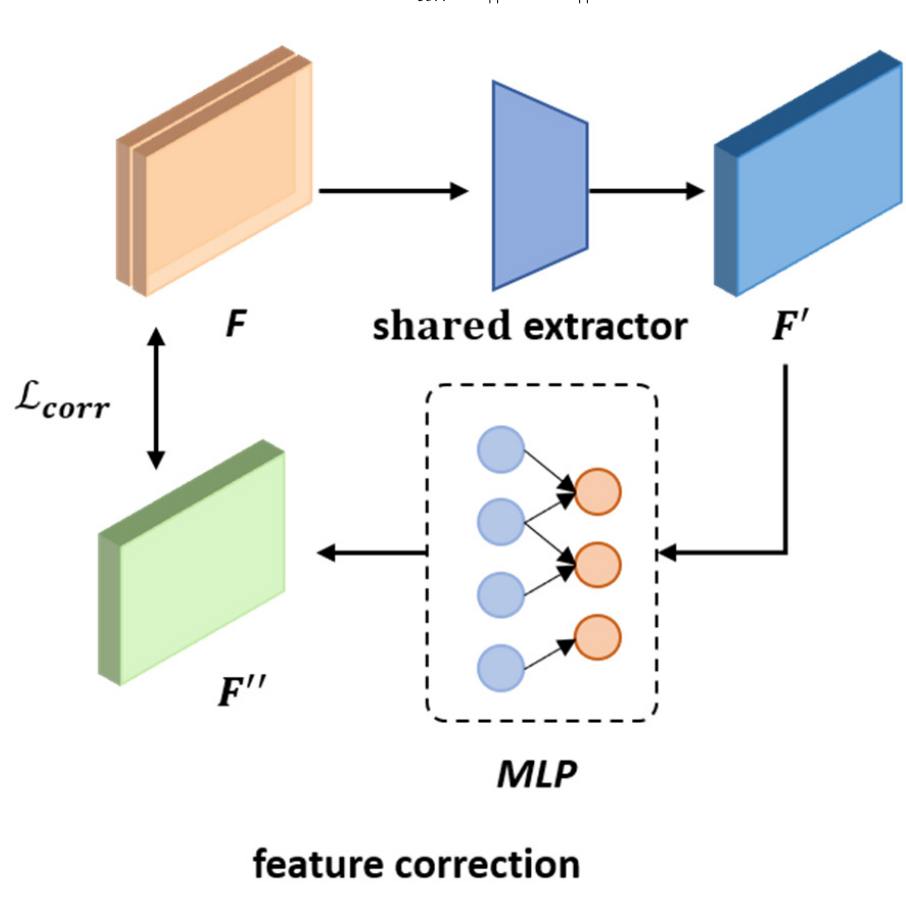
Figure 2. Shared extractor is δ , further extraction and fine-tuning of the features of F , F (cid:48) is the refined feature. The MLP consists of two layers, which adjust the dimension of the feature map of F so that it can correspond to the dimension of F .